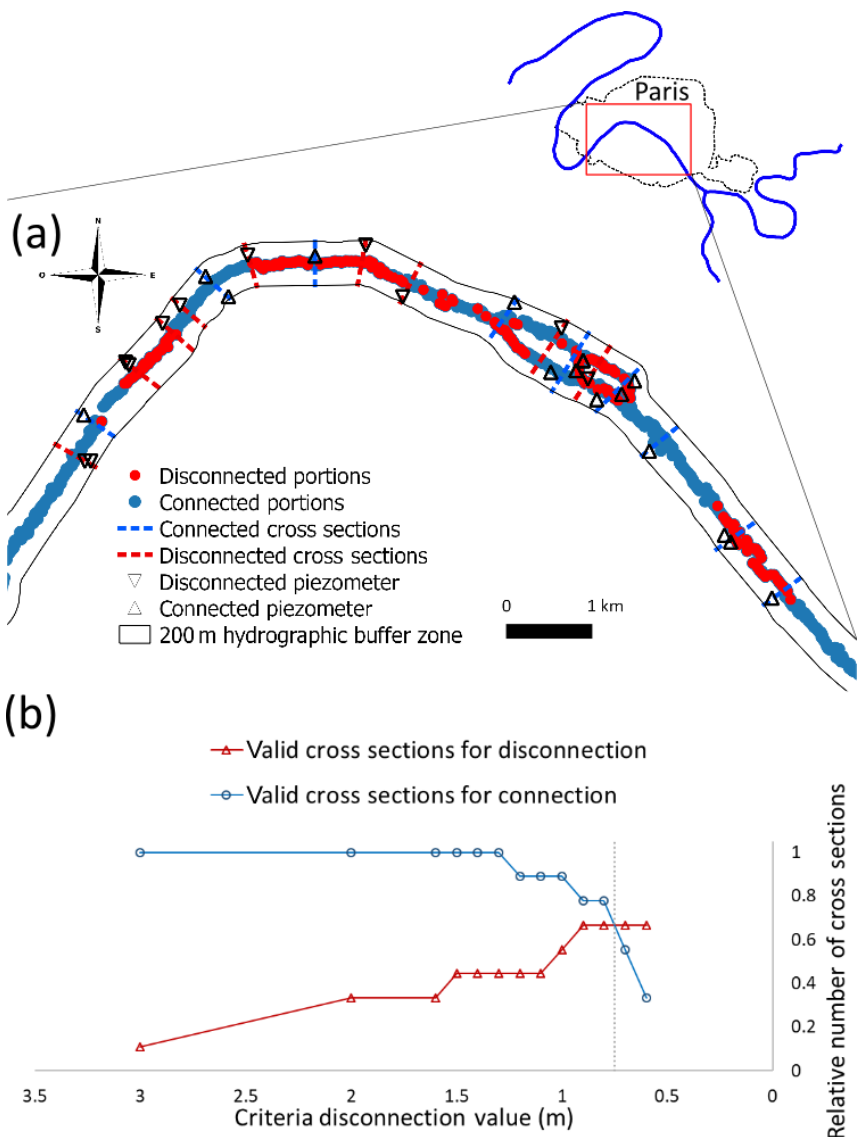
Figure 5. Graphical representation for disconnection criteria adjustment: (a) map of observed SW-GW status related to estimated SW-GW connection status using the optimal 0.75m value for disconnection criteria; (b) relative number of valid SW-GW connection status out of nine disconnected cross sections and nine connected cross